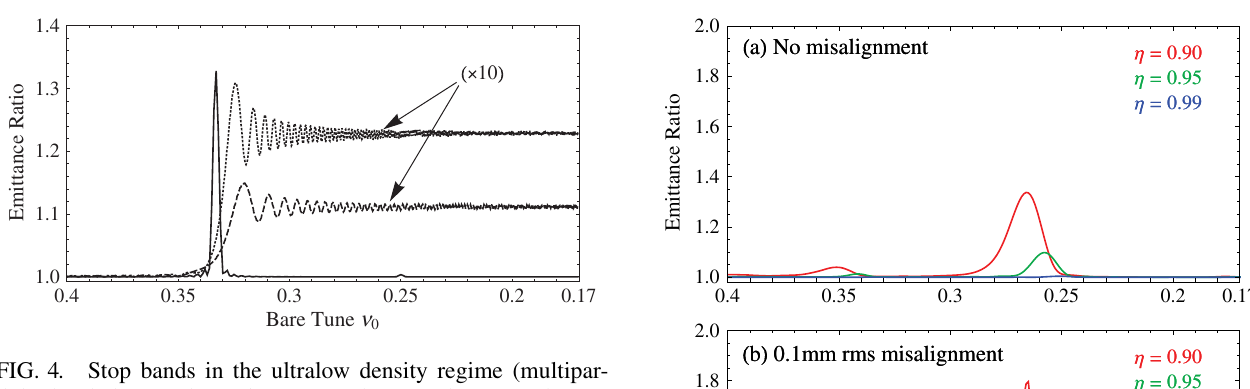
FIG. 4. Stop bands in the ultralow density regime (multipar- ticle simulation results without space charge). The rms emittance of an ion plasma after 0.1 ms storage in the LPT was evaluated with the WARP code at many different fixed tunes in the range (cid:4) 0 : 4 . The final emittance has been normalized by 0 : 17 (cid:4) (cid:5) 0 the initial value. For direct comparison, the simulation data in Figs. 3(a) and 3(b) (10 times exaggerated) are replotted here with dotted and broken lines. The nonlinear-field enhancement due to electrode misalignments has been taken into account as in Fig.